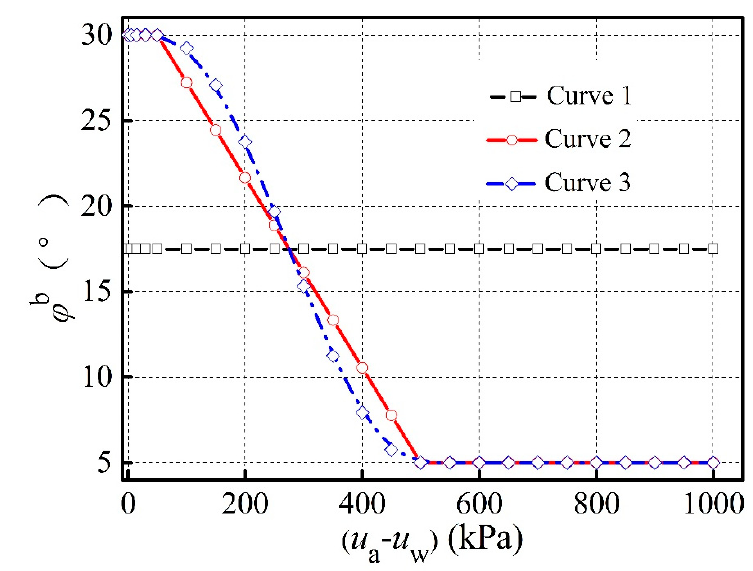
Figure 12. Correlation curves between φ b and ( u a - u w ).